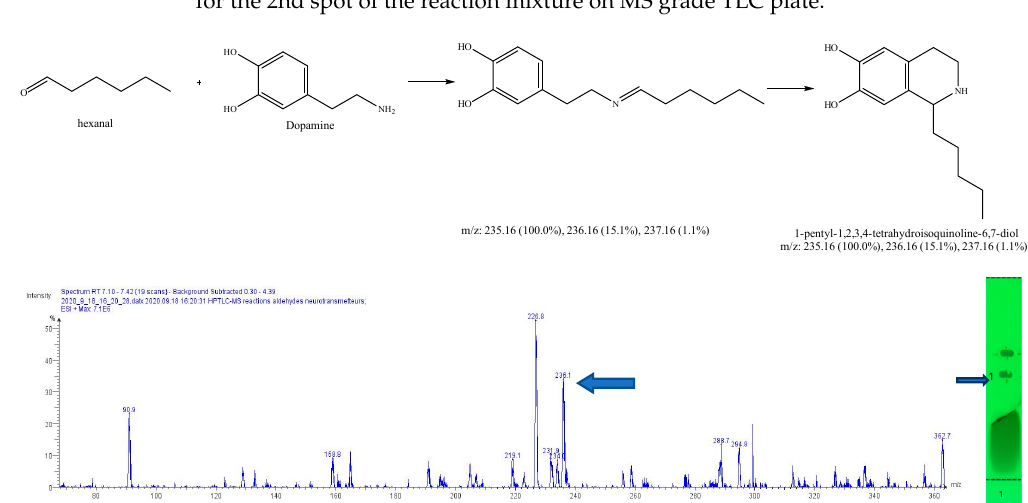
Figure 10. Expected reaction between dopamine and hexanal. Mass spectrum for the 1st spot of the reaction mixture on MS grade TLC plate.